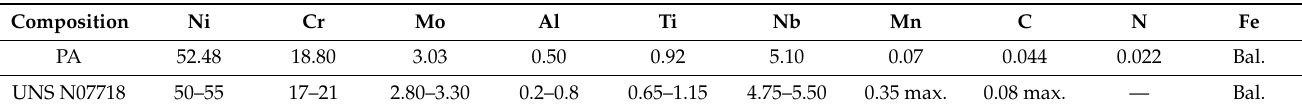
Table 1. Chemical composition of plasma-atomized (PA) Inconel 718 alloy powder and corresponding specification UNS N07718 (in